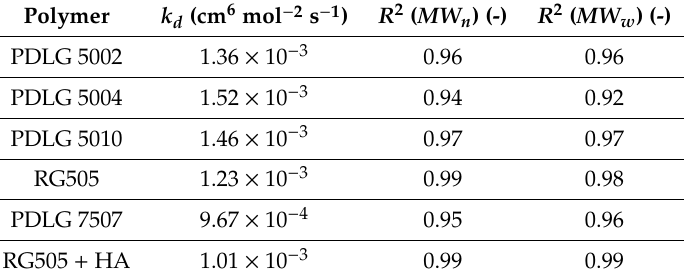
Figure 5. Mass loss ( a ), water uptake ( b ), and pH of the surrounding medium ( c ) as a function of degradation time. Values are expressed as the arithmetic average of three independent measurements ± standard deviation. Table 2. Hydrolysis kinetic constant k d and R 2 values for each data set.